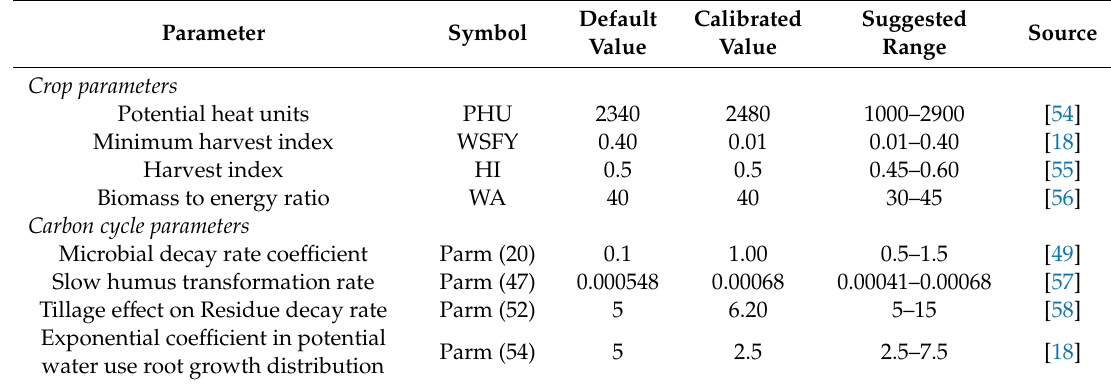
Table 3. Crop and carbon cycle-related parameters, default values, suggested parameter ranges, and calibrated values in the EPIC